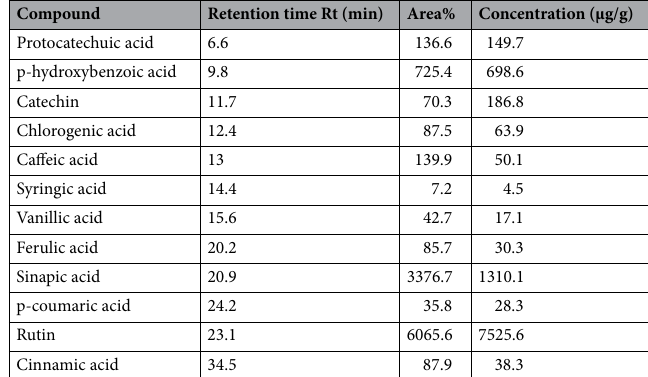
Table 1. Analysis of phenolic compounds of LSE using